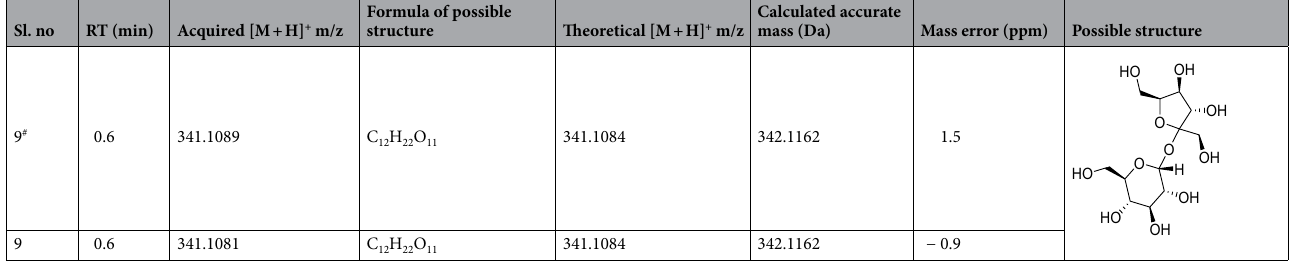
Table 2. Chemical profile analysis of selected active compounds of PHELA (indicated #) and individual plants.